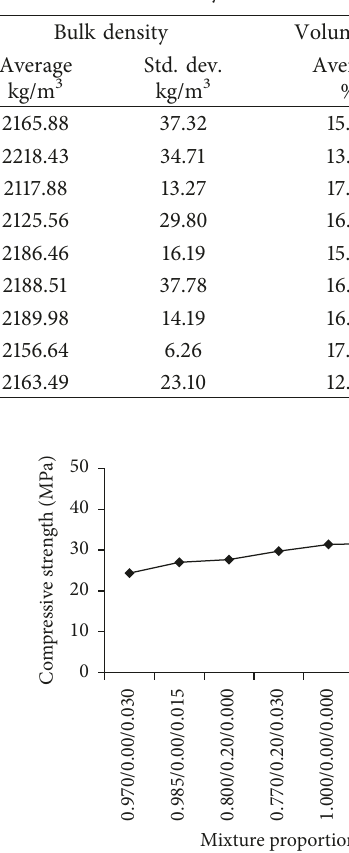
Table 4: Average result of performance measures at day 7.